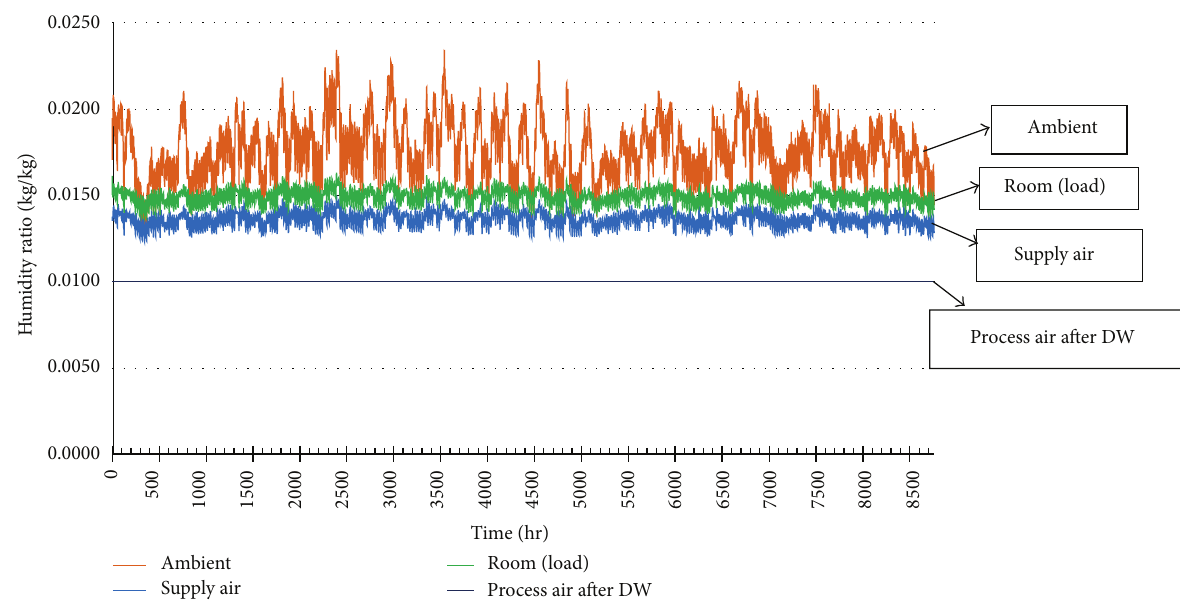
Figure 9: Humidity ratio (kg/kg) of different components versus time (hr) in recirculation mode.